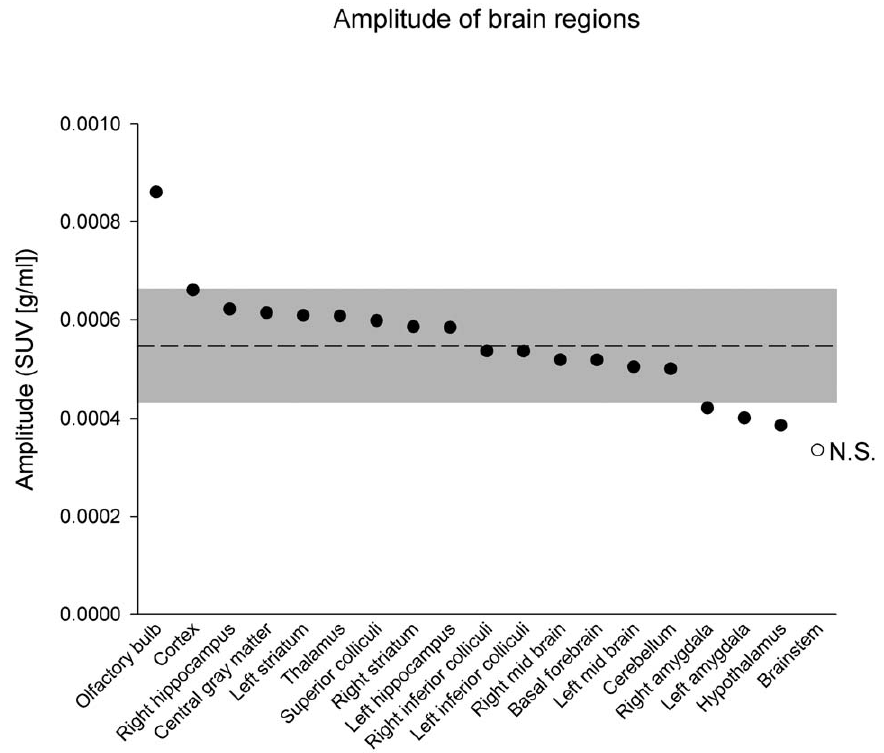
Figure 4. Amplitude of total FDG uptake in specific brain regions. All brain regions, except the brain stem, show significant variations with time (Proc mixed, a =0.05). The dashed line indicates the average and gray area indicates average 6 standard deviation.